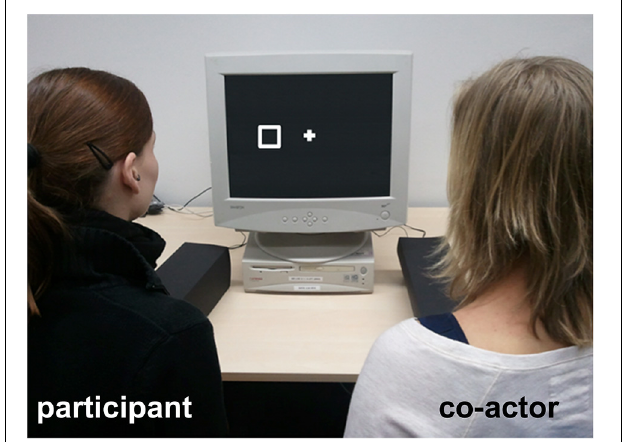
FIGURE 1 | Experimental setup used in Experiment 1. The participant (sitting on the left side of the monitor) shared a joint go/nogo Simon task with a co-actor (confederate) who either intentionally controlled a response button, and could be perceived as the initiator of the button press (agency + /intentionality + condition) or whose response button was controlled by the computer so that the co-actor was not the initiator of the button press and did not respond intentionally (agency − /intentionality − condition). Perceptual differences between the response button of the actively responding co-actor and the computer controlled response button were controlled for during task performance by covering response hands and letting both persons wear earplugs, so that the setup shown on the picture applies to both, the agency + /intentionality + and the agency − /intentionality −